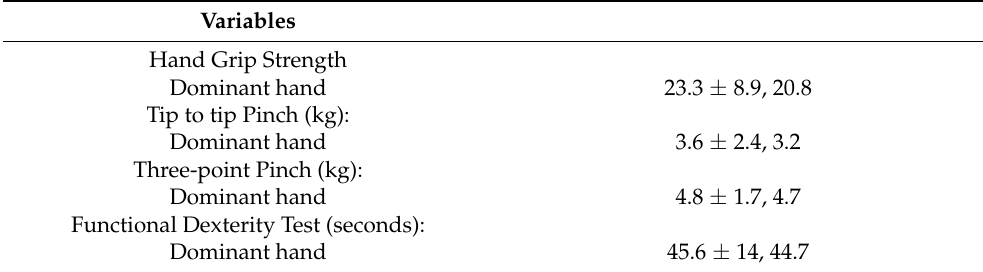
Table 2. Results of the traditional hand function assessment (Mean, SD,